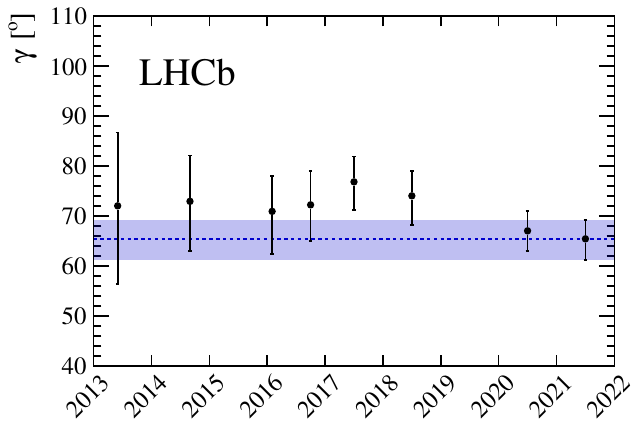
Figure 10 . Evolution of the LHCb combination result for γ , with the central values and 1 σ uncertainties in black. This result is the 2021 data point, the value and uncertainty are highlighted by the dashed blue line and band,